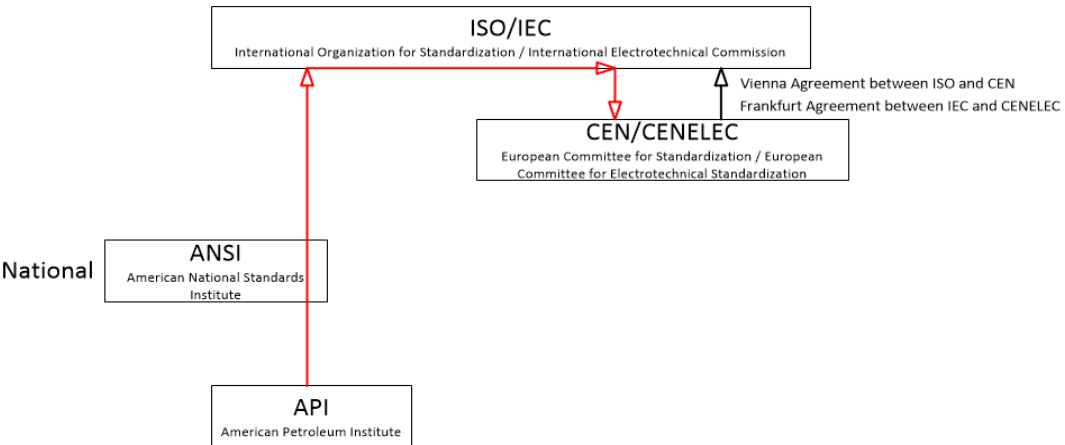
Figure 1. CEN/CENELEC harmonization of API standards with the appropriate EU/EEA directives Figure 1. CEN / CENELEC harmonization of API standards with the appropriate EU / EEA directives through ISO/IEC following the Vienna and Frankfurt Agreements. through ISO / IEC following the Vienna and Frankfurt